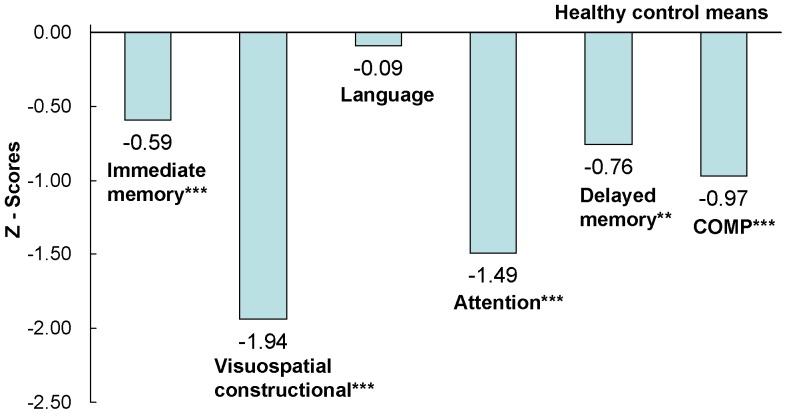
Magnitude of impairment relative to healthy controls in the RBANS.Numbers of the figure are Z-score. **p<0.01, ***p<0.001.